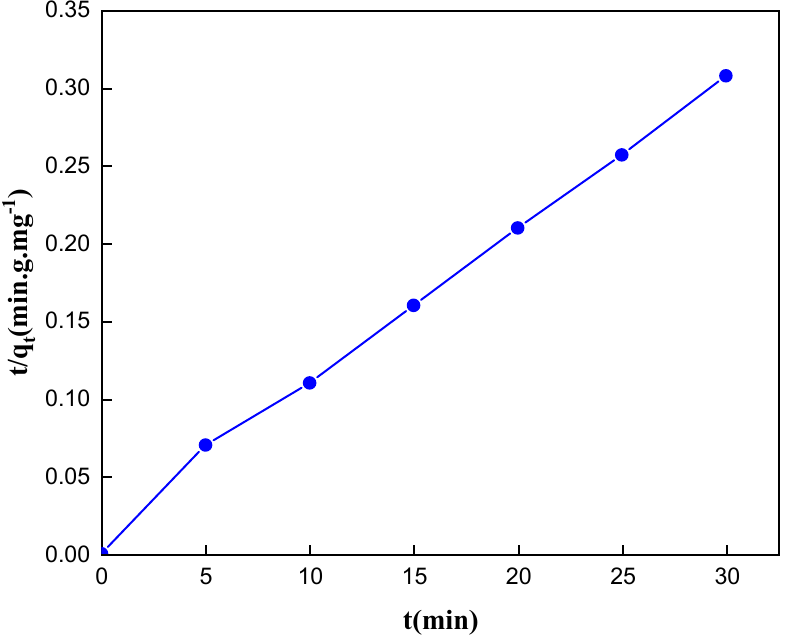
Figure 7. Pseudo-second-order model fit for the adsorption of Cu(II) by SiN-imd-py Figure 7 . Pseudo-second-order model fit for the adsorption of Cu(II) by SiN-imd-py .